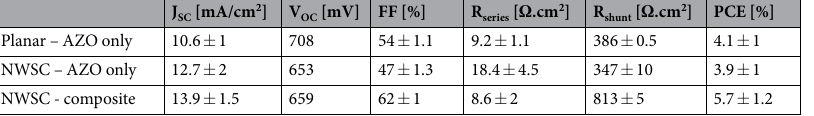
Table 1. Device characteristics of the NWSC with and without the AZO/Ag NW composite top electrode. Planar device characteristics are also shown for comparison.